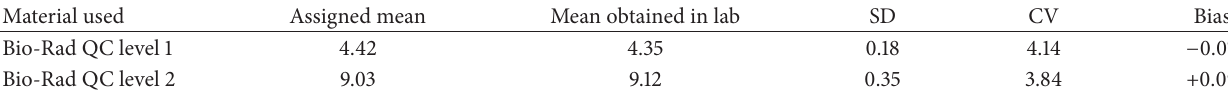
Table 3: Calculation of precision and bias.